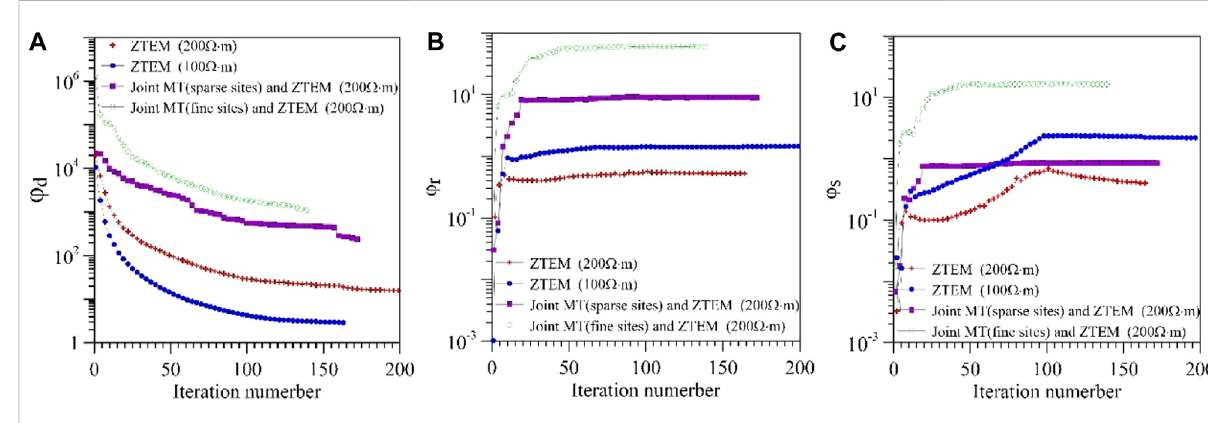
Table 3. Start model 1 is a ZTEM inversion with a 200 Ω ·